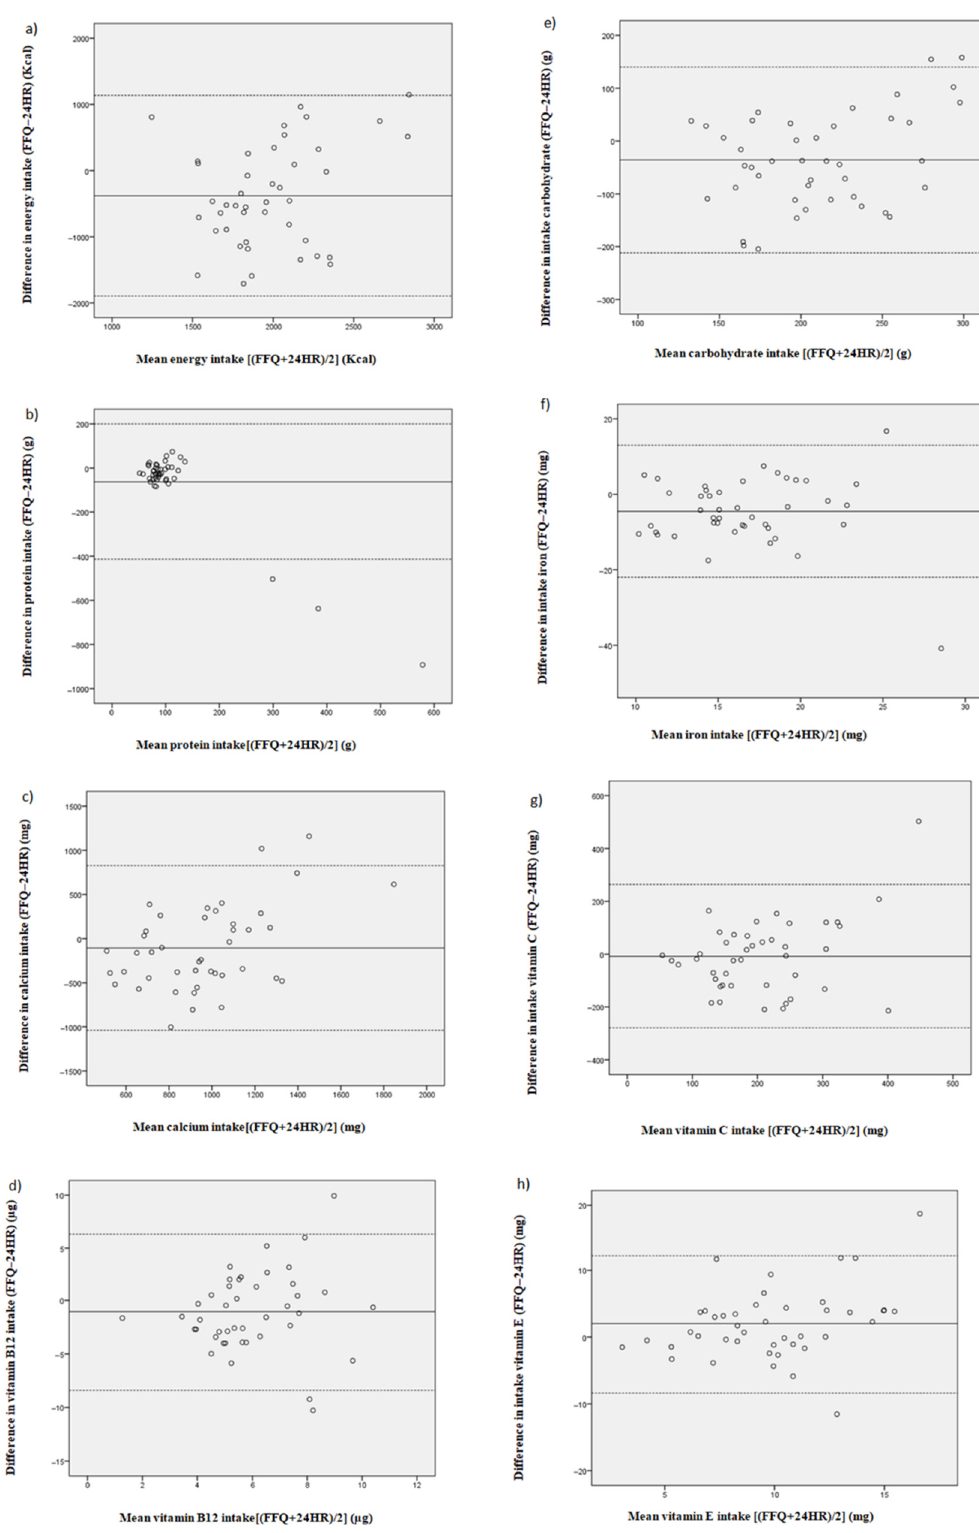
Figure 1. Bland–Altman plot. Bland–Altman plot between food frequency questionnaire (FFQ) and 24-h dietary recalls methods for measuring daily ( a ) energy, ( b ) protein, ( c ) calcium, ( d ) vitamin B12, ( e ) carbohydrate, ( f ) iron, ( g ) vitamin C and ( h ) vitamin E intake. Solid lines represent mean differences between the two methods. Dashed lines represent the limits of agreement corresponding to ±1.96 SD.